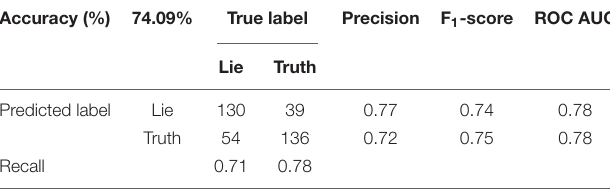
TABLE 8 | Confusion matrix and performance metrics of classification